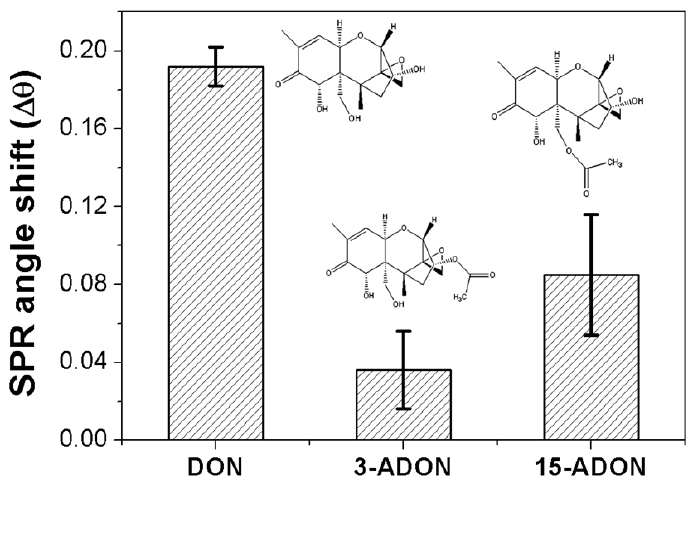
analogs. The SPR angle shift represents the difference in resonance angle before and after the addition of 10 ng/mL of DON or its analogs onto the DON–MIPPy